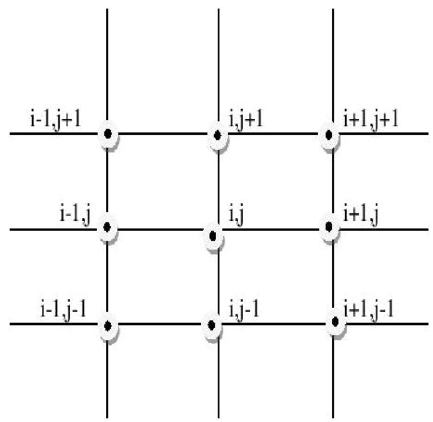
Figure 1. Grid points for the proposed scheme (8).